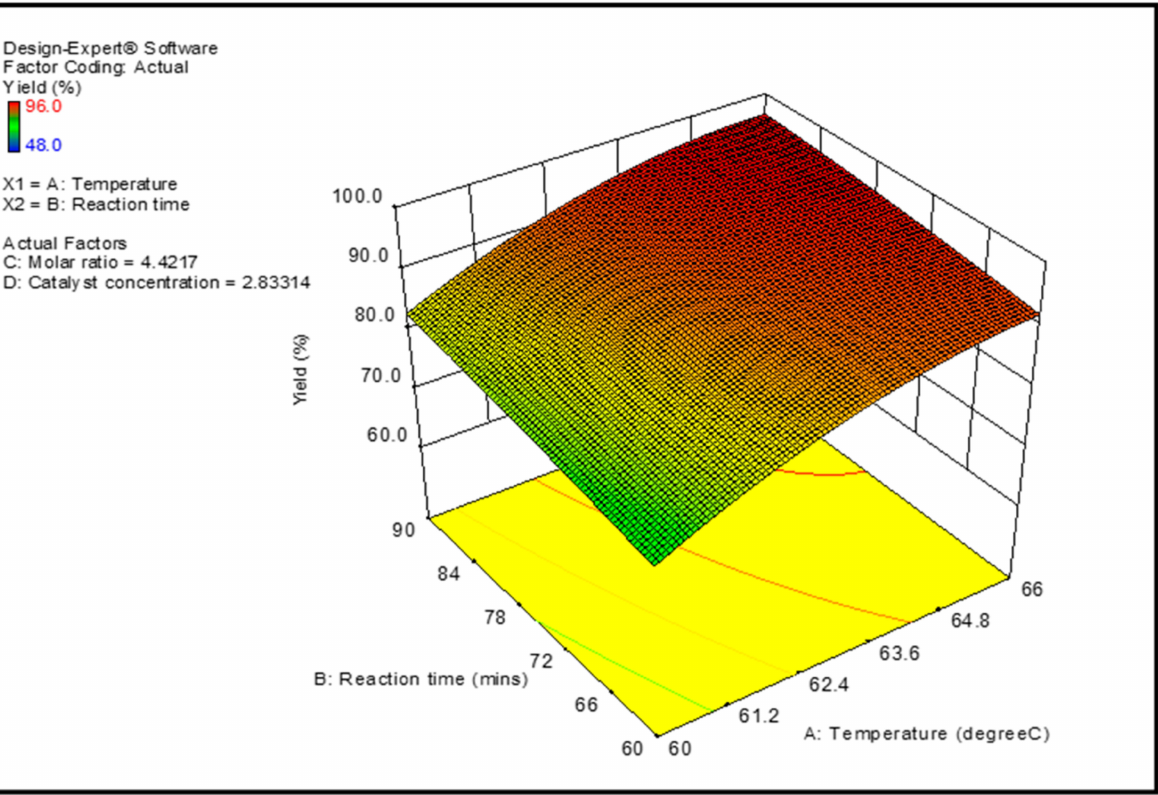
Figure 6. The predicted biodiesel production against the actual output.